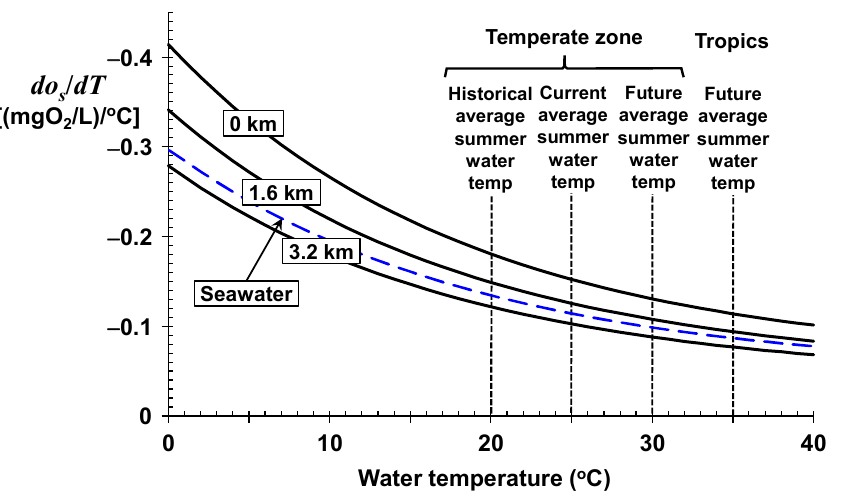
Figure 2. The rate of change of oxygen saturation with respect to temperature ((mgO 2 /L)/ ◦ C) versus temperature ( ◦ C) for freshwater at three elevations (solid lines) and seawater (dashed line). The vertical dotted lines indicate four key temperatures. Table 1. The rate of change of oxygen saturation with respect to temperature ((mgO 2 /L)/ ◦ C) for selected temperatures (°C) for freshwater at three elevations and seawater. T (°C)